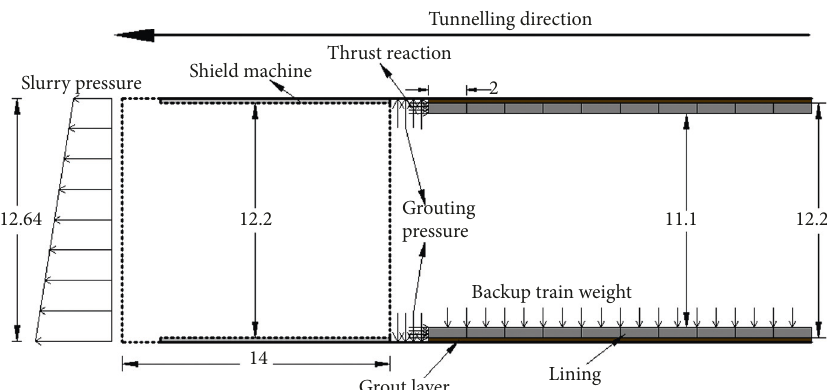
Figure 16: Simulation procedure in FD for shield tunnelling (unit: m).